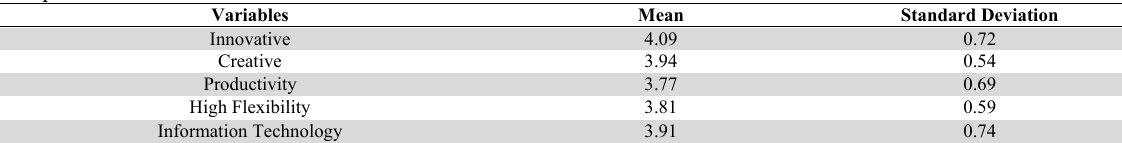
Descriptive Statistics of Variables N= 615